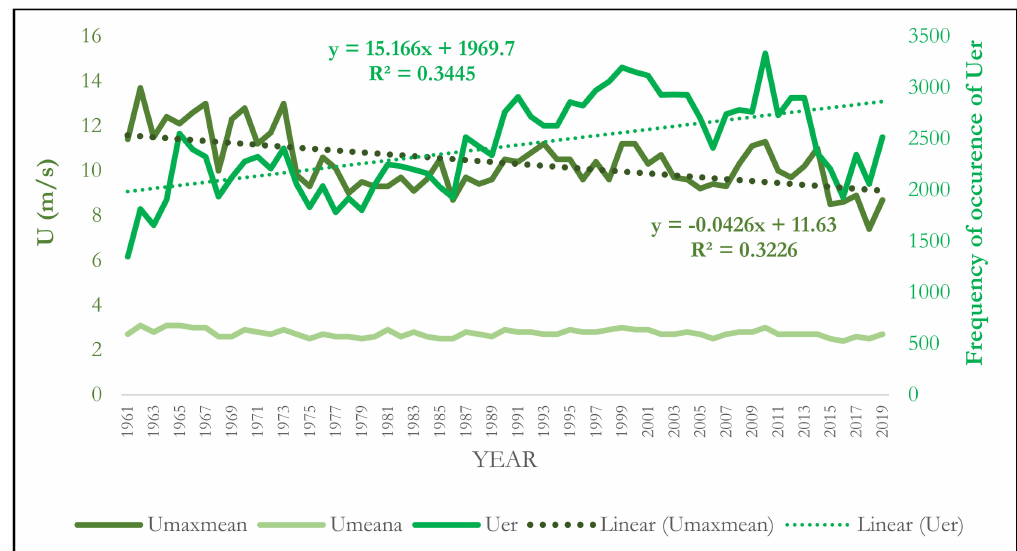
Figure 4. Trends of Umean a , Umax mean , and Uer frequency during study period.